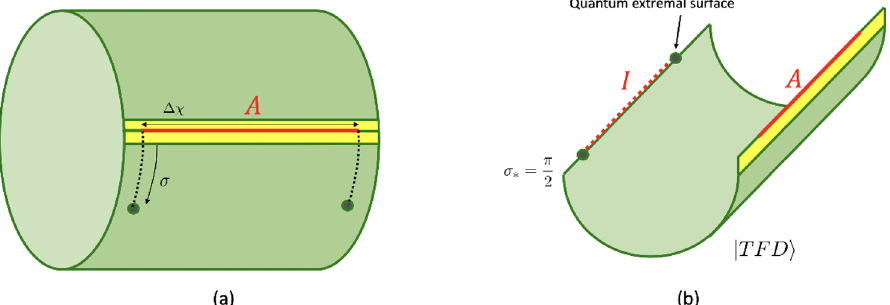
Figure 6 . (a) We are interested in the entropy of a region A with length ∆ χ . One can look for a configuration with two emergent twist operators in the gravity region, and they pair up with the two boundary twist operators of A in the limit ∆ χ (cid:29) 1 . (b) After extremization, the quantum extremal surfaces and the island (denoted by I and the dotted line) are found to be on the throat of the wormhole. The matter entropy that appears in the QES prescription can then be interpreted as the entropy of A ∪ I in a | TFD i